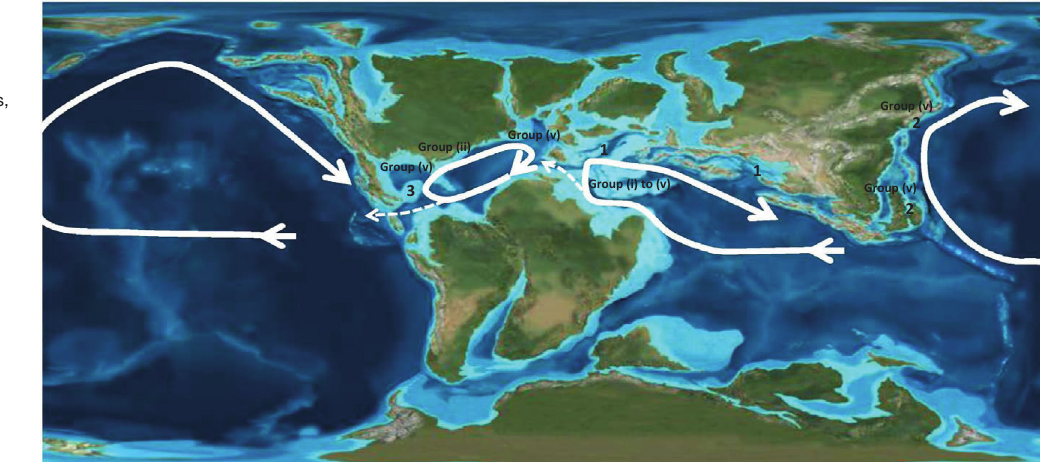
The provincial distribution of the orbitolinids during the Early Cretaceous, Early Albian in the Tethys (1), the Western Pacific (2), and the Americas (3), with paleo-oceanic currents shown by the white